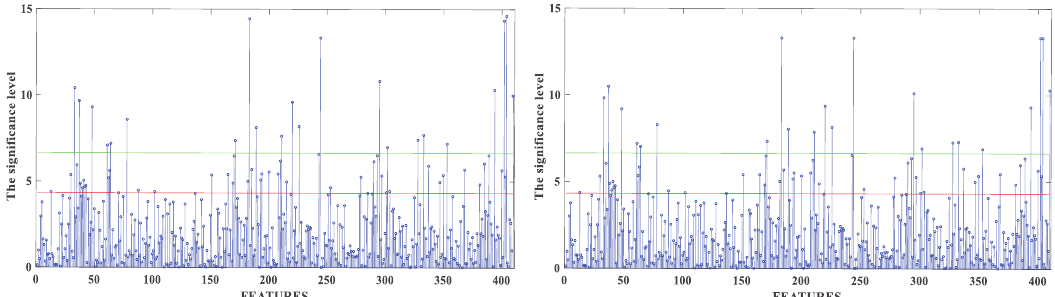
Figure 5. The results obtained by the Kendall correlation coefficient. The x axis corresponds to the features, and the y axis is the absolute value of the Kendall tau correlation coefficient.